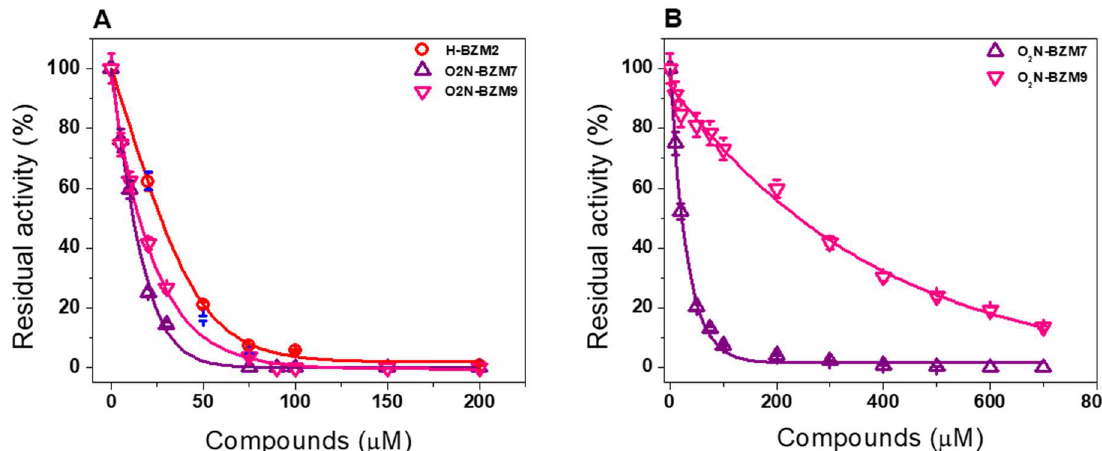
Figure 2. G6PD::6PGL enzyme inactivation assays with compounds. Effect of compounds H-BZM2 , O 2 N-BZM7 , and O 2 N-BZM9 on ( A ) GlG6PD::6PGL and ( B ) TvG6PD::6PGL. The protein was ad- justed to a concentration of 0.2 mg/mL and incubated with increasing concentrations of each com- pound for 2 h at 37 °C. At the end of the incubation time, residual activity was measured. Results are shown as the mean values of three independent tests.